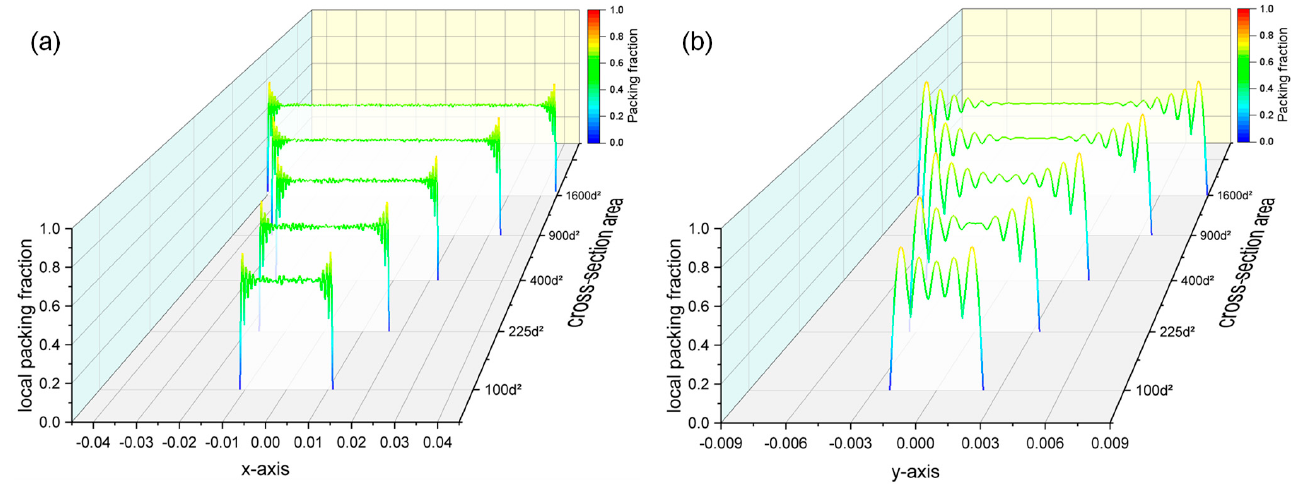
Figure 13. Axial packing fraction variations along the ( a ) x -axis (longer edge) and ( b ) y -axis (shorter edge) in pebble beds with a fixed aspect ratio of 5 and various cross-sectional areas of 100 d 2 –1600 d 2 (Color online).